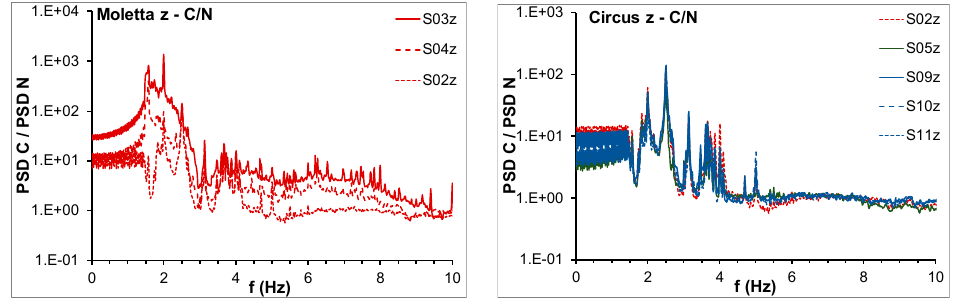
Figure 13. Ratios between the spectra during C and N. Furthermore, the vertical component at the foot of the tower (S02x) is greater than the horizontal components (S02x and S02y). This resonance frequency does not seem to be linked to the characteristics of the soil, but is probably due to the presence of buried structures. The rotate spectrum analysis (Figure 14) helped to identify the angle of the maximum spectral amplitude, which remains unchanged during the three time intervals (T, C, and N). Figure 14. Circus: Horizontal spectra rotate at S02, S05, and S09 in C. The CDSs plotted in Figure 15 often show significant values of the phase factor and the coherence function between the records at different locations, validating the hypothesis about presence of buried structures.